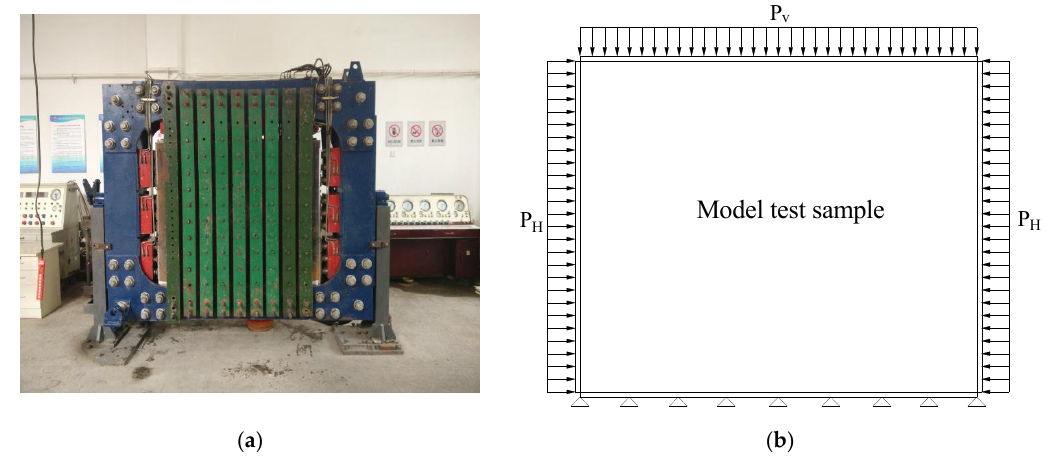
Figure 1. Multifunctional testing machine for the rock and soil: ( a ) test equipment; ( b ) static loading schematic.